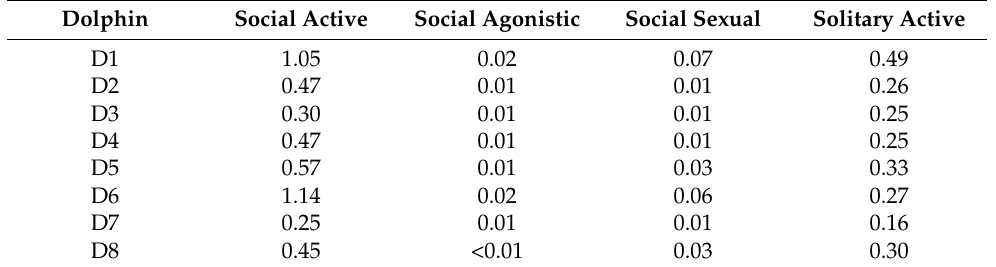
Table 3. Rates of behaviors in the social active, social agonistic, social sexual, and solitary active categories. Dolphin Social Active